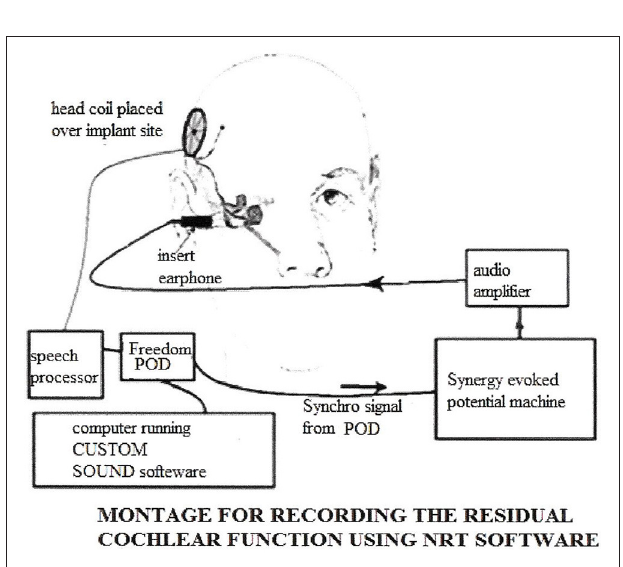
FIGURE 8 | Click evoked AP during a stapedectomy procedure.